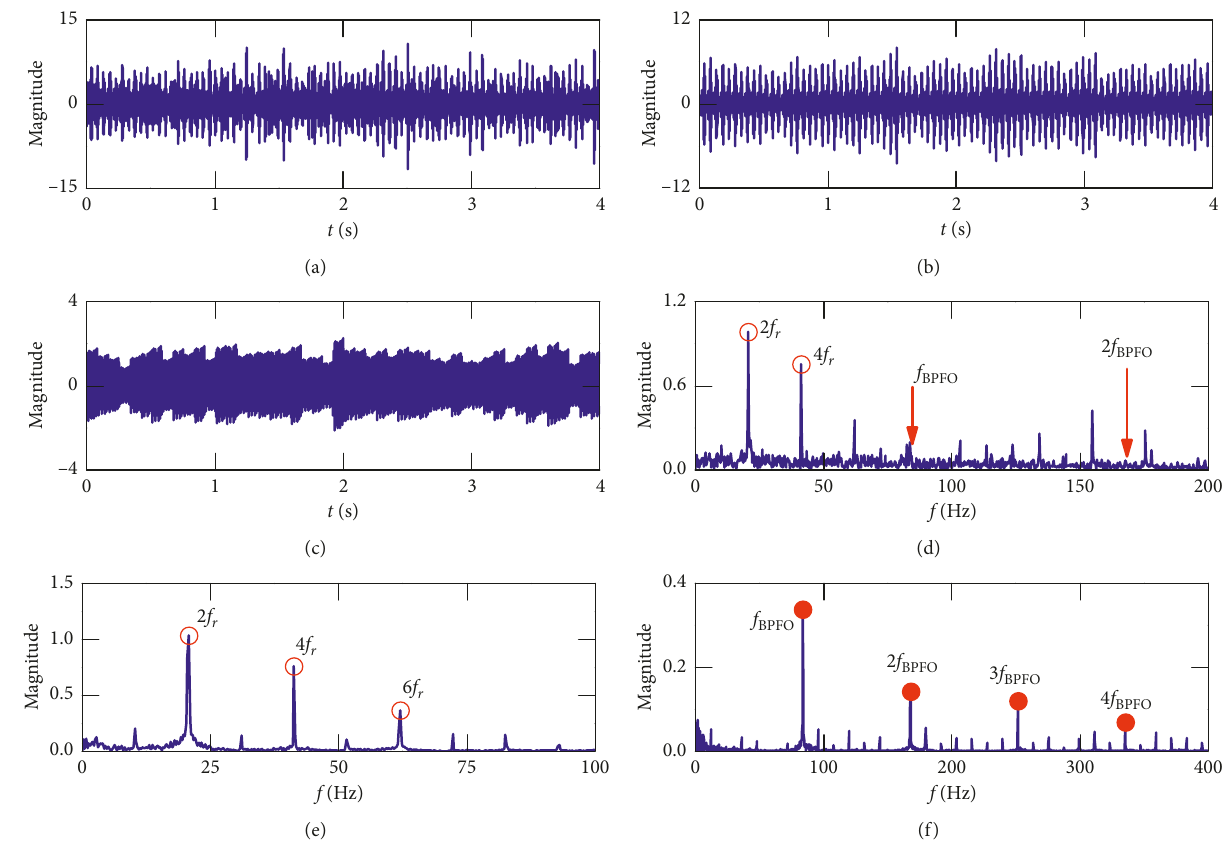
Figure 12: Results obtained by the proposed CPS for a bearing outer race fault signal: (a) IMF 3; (b) first periodic impact component extracted from (a); (c) second periodic impact components extracted from (a); (d) squared envelope spectrum of (a); (e) squared envelope spectrum of (b); (f) squared envelope spectrum of